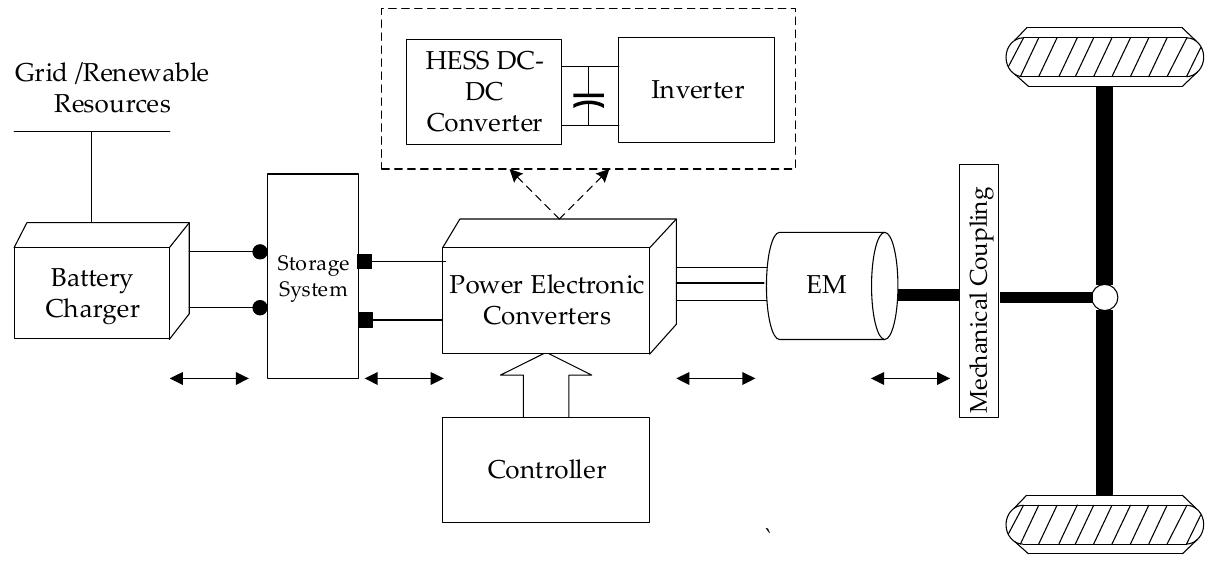
Figure 1. Block diagram of BEV propulsion system.